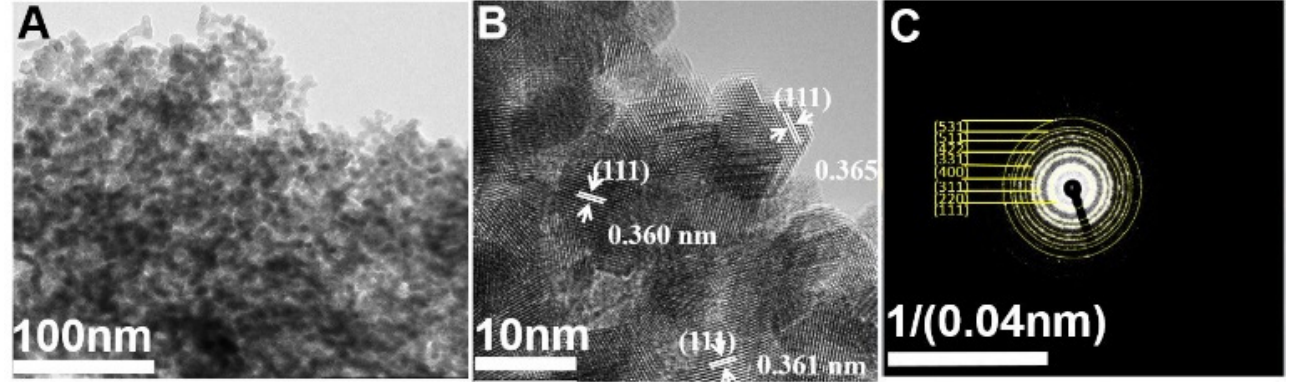
Figure 2. ( A ) TEM image, ( B ) HRTEM and ( C ) SAED pattern of CeO 2 nanoparticles.